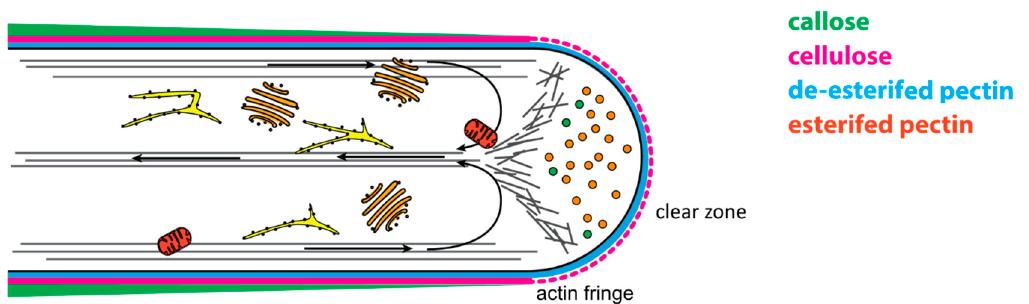
Figure 1. Tip-growing pollen tubes require a distinct subcellular organisation. The abundant secretion processes at the pollen tube tip lead to a distinct structuration in growing pollen tubes. The apex of the growing tube is packed with secretory vesicles and void of organelles leading to a V-shaped “clear zone”. It is speculated that the organelles are prevented from entering that zone by the cortical actin structure of the actin fringe. Behind the actin fringe, F-actin forms strong actin bundles required for transport processes. Vesicles and organelles, like mitochondria (depicted in red), endoplasmic reticulum (yellow), and Golgi (orange) structures, are transported on cortical actin bundles towards the tip. Retrograde transport takes place on central actin cables, resulting in a “reverse fountain” pattern of cellular transport. Additional structuration can be observed in the pollen tube cell wall. Esterified pectins predominantly form the cell wall at the pollen tube tip, although the presence of cellulose has been reported in some cases. Further back, cellulose and callose are embedded in a pectin matrix of de-esterified pectin monomers crosslinked with Ca2+ ions, leading to increased stiffness of the shank cell wall.